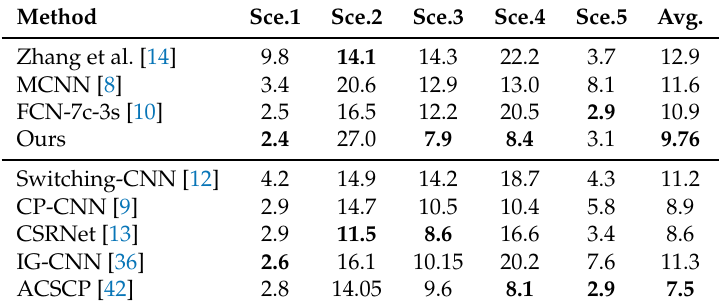
Figure 7. Density estimation results on the WorldExpo’10 dataset [14]. ( a ) Input images, ( b ) ground truth density maps, and ( c ) estimation results. Table 6. Comparison of the networks on the WorldExpo’10